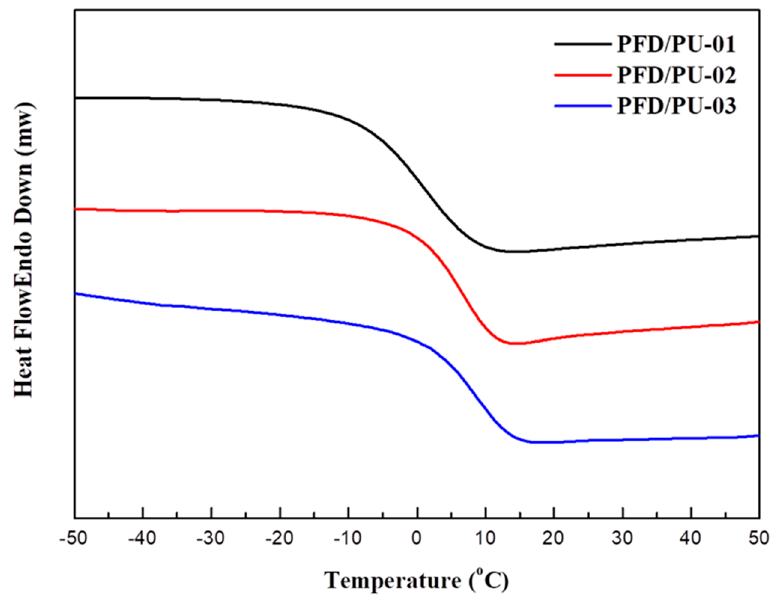
Figure 14. DSC thermograms of PFD/PUs.